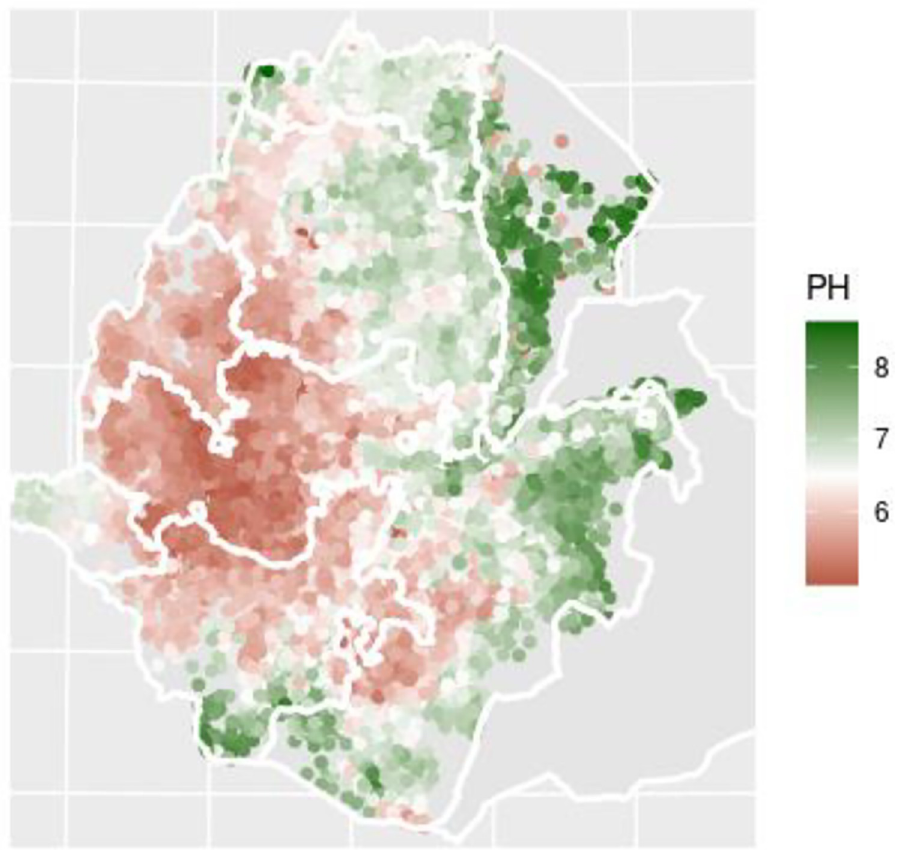
Fig 1. Ethiopia’s soil pH balance. Contains information from OpenStreetMap and OpenStreetMap Foundation, which is made available under the Open Database